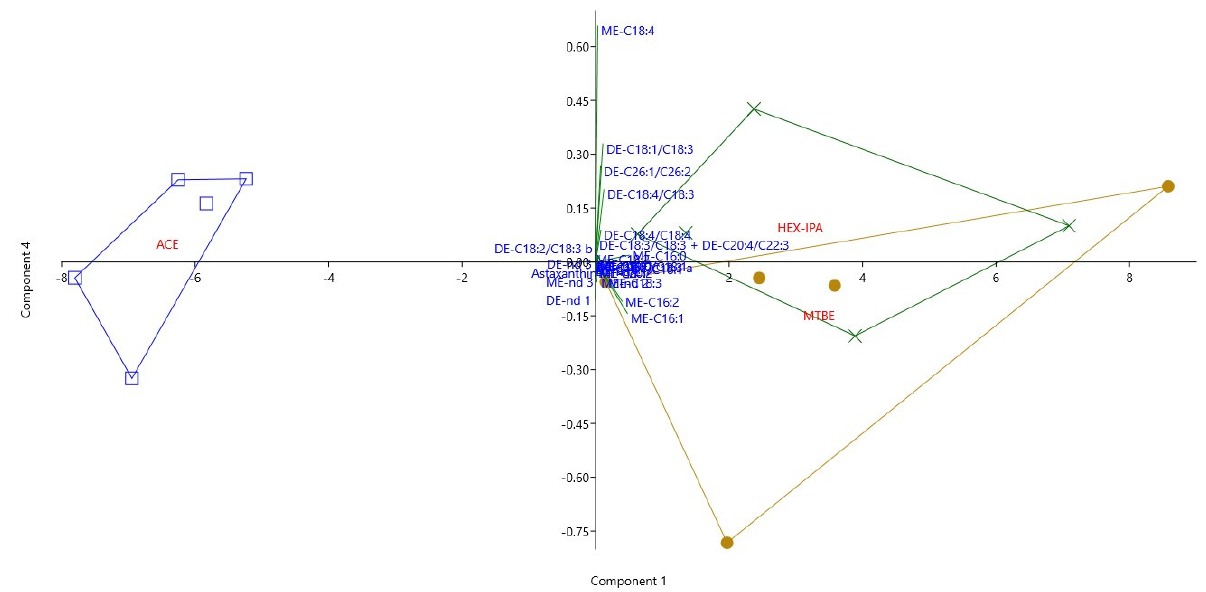
Figure 4. Principal component diagram (PCA) of astaxanthin derivatives (free astaxanthin, astaxanthin monoesters − ME and diesters − DE) in relation to different extraction solvents: ACE (blue square), HEX-IPA (green cross) and MTBE (dark golden dot). For detailed statistics, see Table 3.